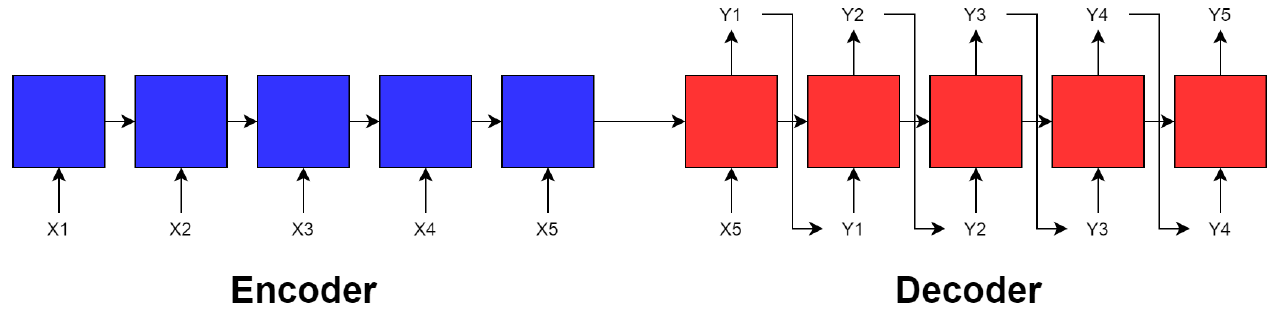
Figure 1. Diagram of Seq2Seq